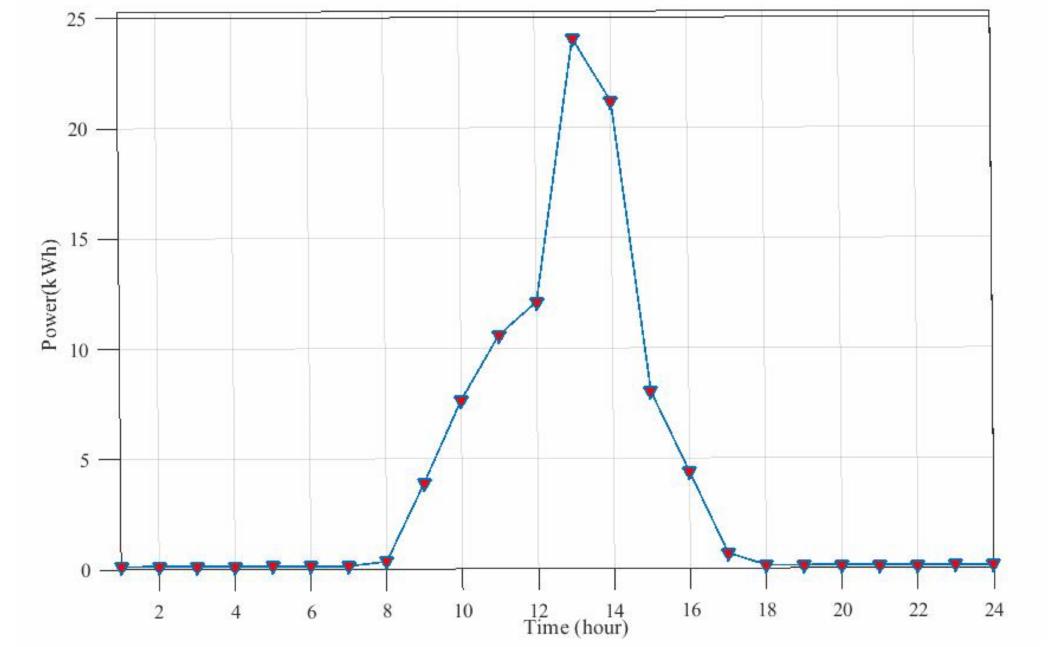
Figure 6. Forecasting power of photovoltaic unit